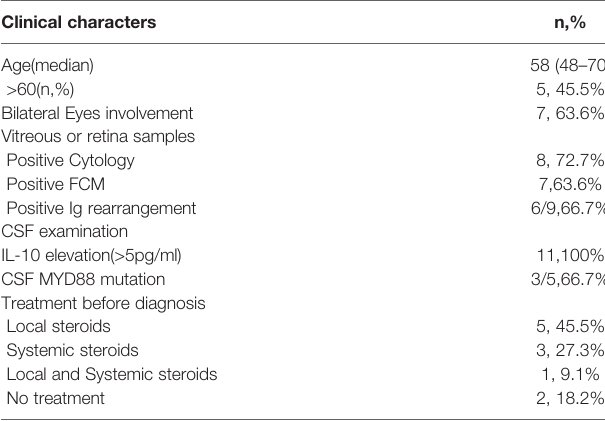
TABLE 1 | Clinical characteristics of 11